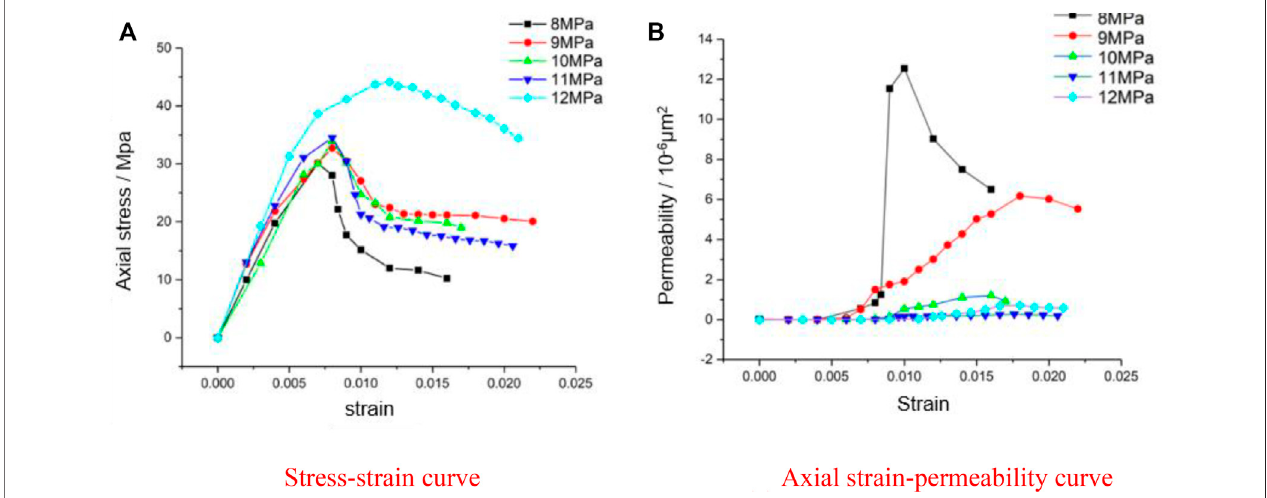
FIGURE 4 | Stress-strain-permeability curves of each specimen under different con fi ning pressures. (A) : Stress-strain curve. (B) : Axial strain-permeability curve.